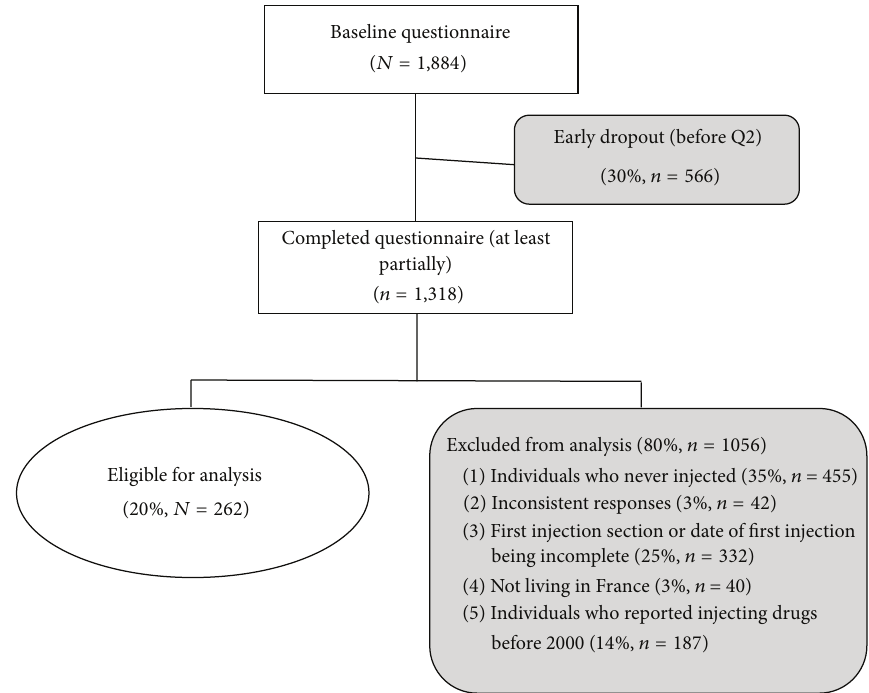
Figure 1: Flow chart of data cleaning and exclusion criteria from the